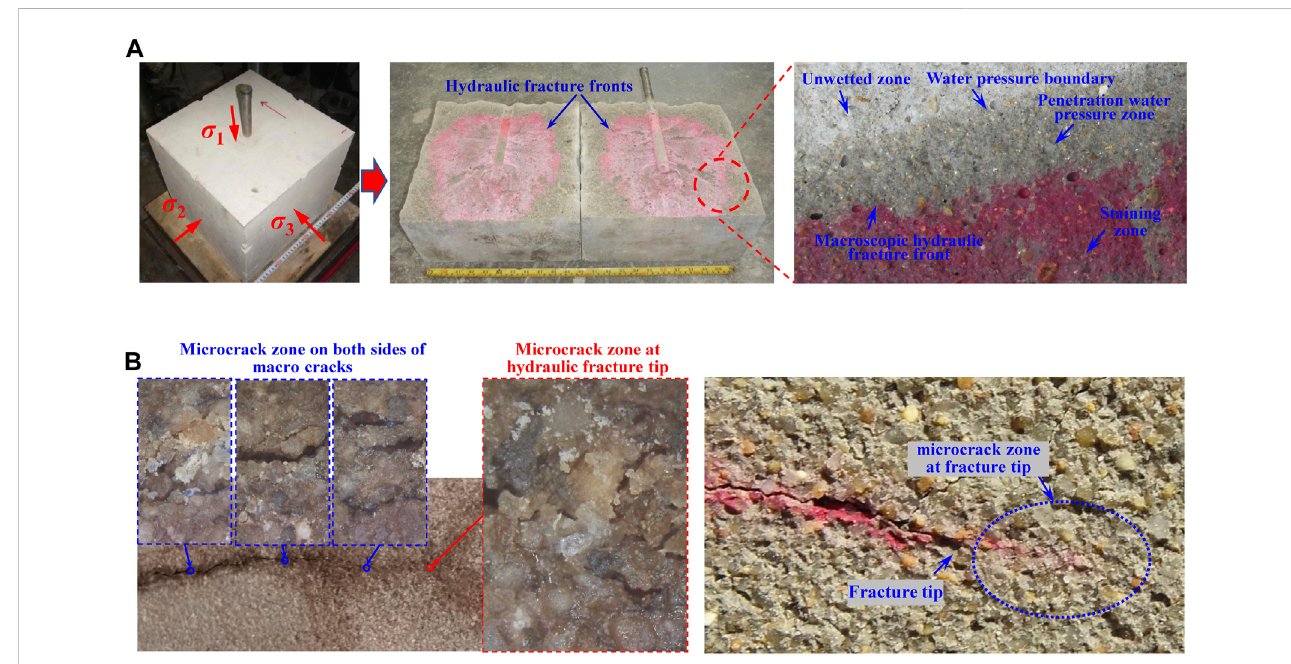
FIGURE 1 Rock hydraulic fracturing. (A) Hydraulic fracturing in borehole under true triaxial stress and permeability water pressure zone morphology at hydraulic fracture tip; (B) Microcrack zone at hydraulic fracture